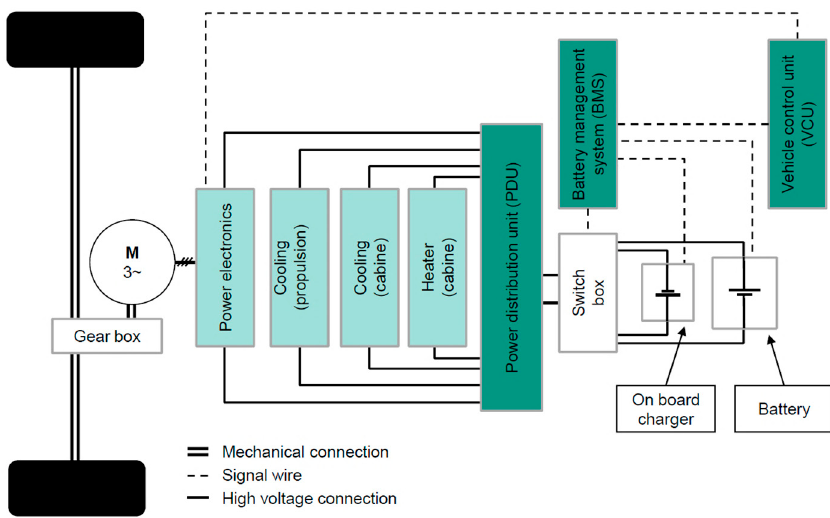
17 of 18 Table C1. Technical data of electric motor.